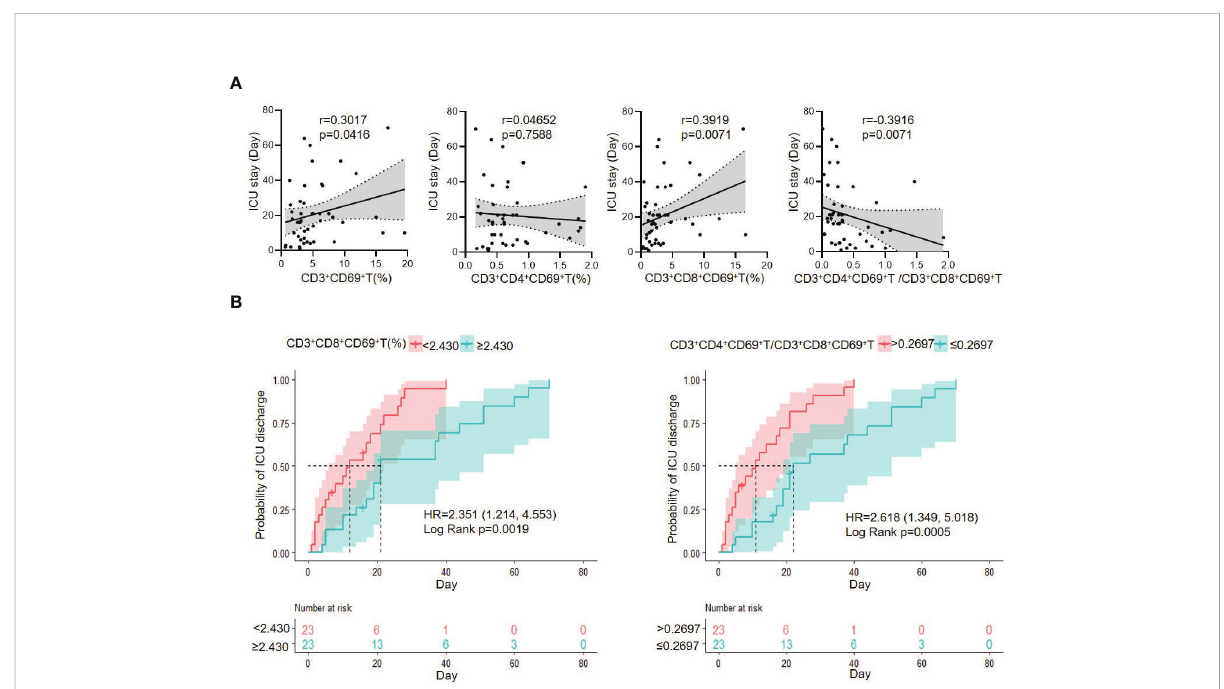
FIGURE 4 The correlation of CD3 + CD69 + T cell subset with ICU stay, and Kaplan – Meier analysis of probability of ICU discharge according to CD3 + CD69 + T cell subsets in G - bacterial sepsis group. (A) Correlation of ICU stay and CD3 + CD69 + T cell subsets in G - bacterial sepsis group. (B) Kaplan – Meier analysis of probability of ICU discharge according to CD3 + CD69 + T cell subset in G - bacterial sepsis group. HR, hazard ratio; 95%CI, 95% con fi dence